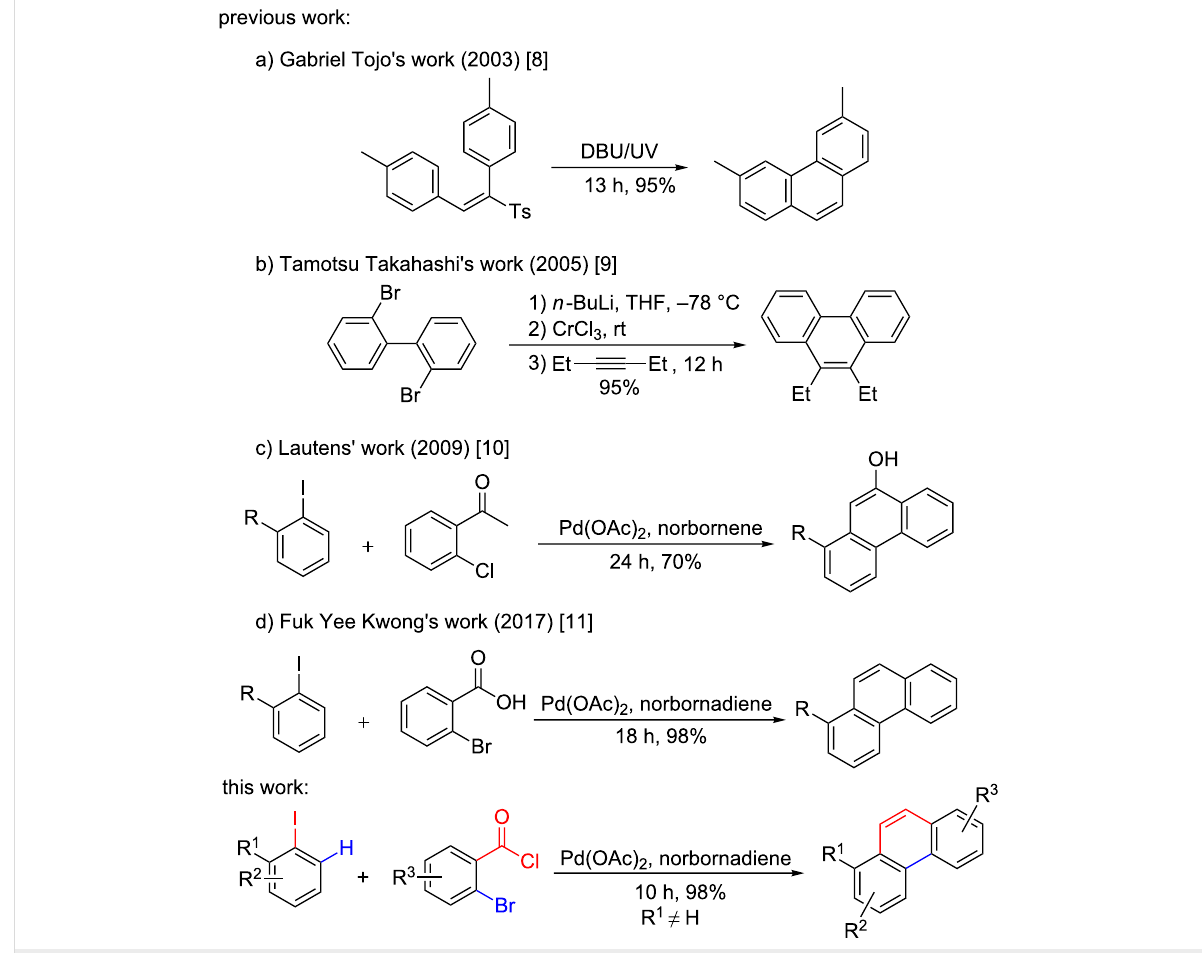
Scheme 1: Different methods for the synthesis of phenanthrene